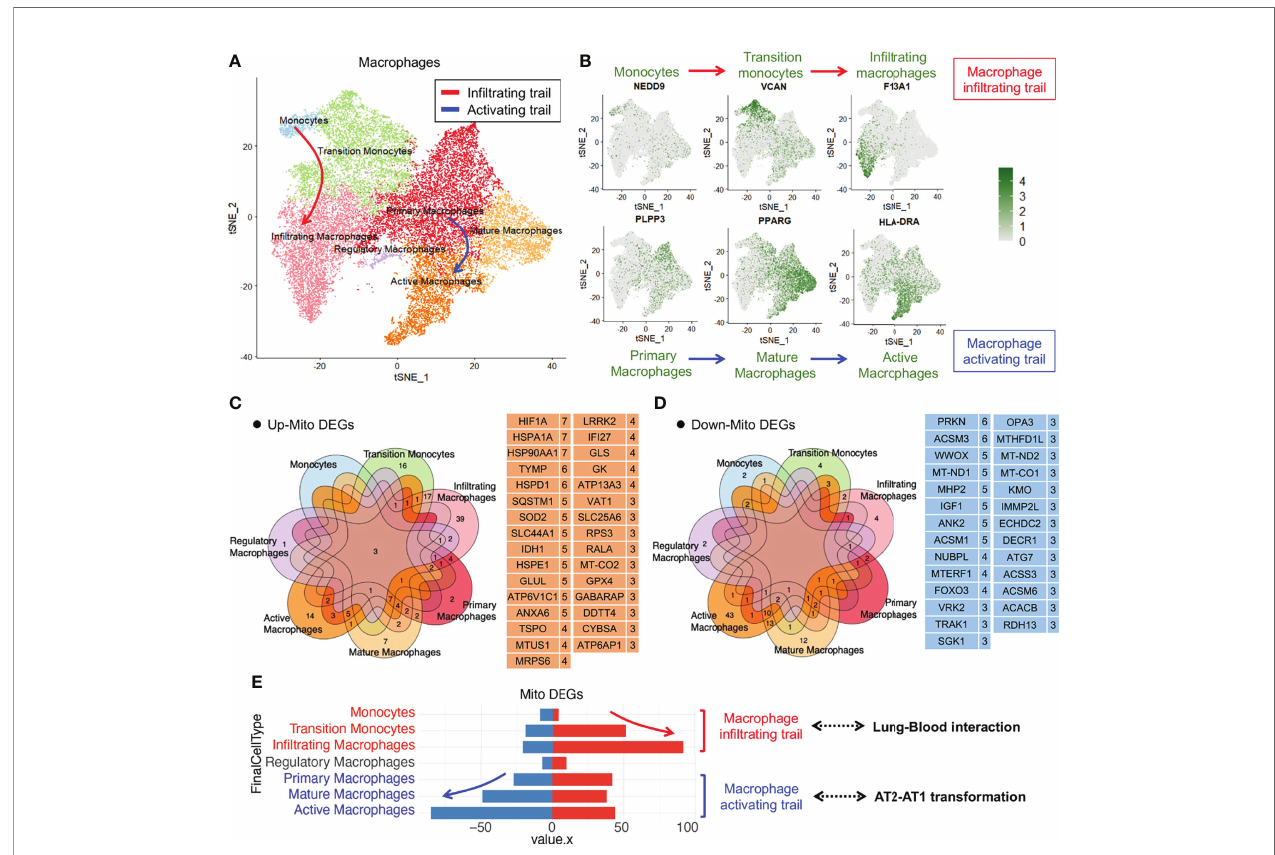
FIGURE 2 | Immune macrophage transformation in the lung tissue from COVID-19 patients. (A) T-distributed stochastic neighbor embedding (tSNE) projection highlighting immune macrophage transformation trails. Red arrow represents macrophage in fi ltrating trail and blue arrow represents macrophage activating trail. (B) tSNE of representative markers RNA expression showing macrophage transformation trails. (C) Upregulated mitochondrial differentially expressed genes (mito-DEGs) of macrophage subsets in COVID-19. (D) Downregulated mito-DEGs of macrophage subsets in COVID-19. (E) Statistical analysis of mito-DEGs, accompanied by the transformation of macrophage in fi ltrating and activating